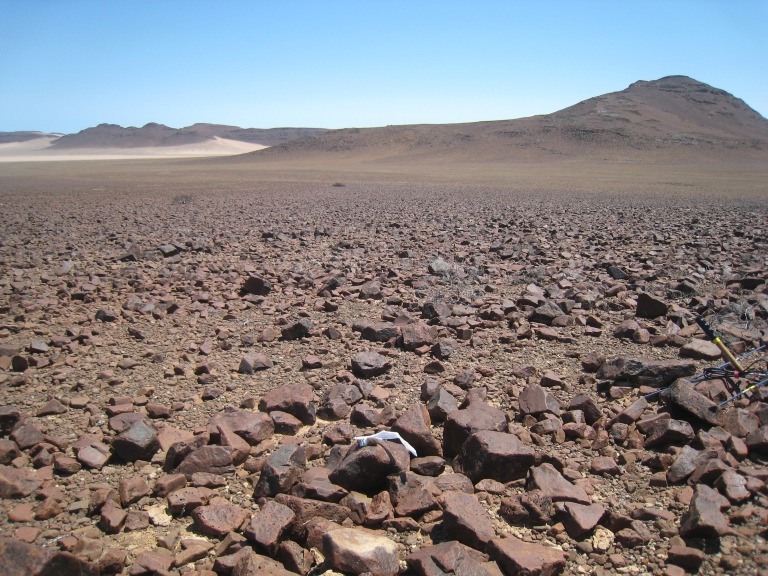
Study site in eastern Goboboseb Mountains, northwestern Namibia.View from the northern end of #4947M home range looking south across home range area of #4020F (see Fig. 3). White flagging on top of rock in foreground is a day shelter of #4947M. Boscia bush in far middle of image was used as a shelter at night (see ‘Results’). The alluvial plains between the Boscia bush and the sand dunes in far distance, beyond rust-colored rocky Macroscelides micus habitat in foreground, were rarely used by M. micus, but are likely habitat of M. flavicaudatus. Wooden handle of radio-tracking antenna on right margin of image is 30 cm long. Photo 23 October 2014 by GBR.